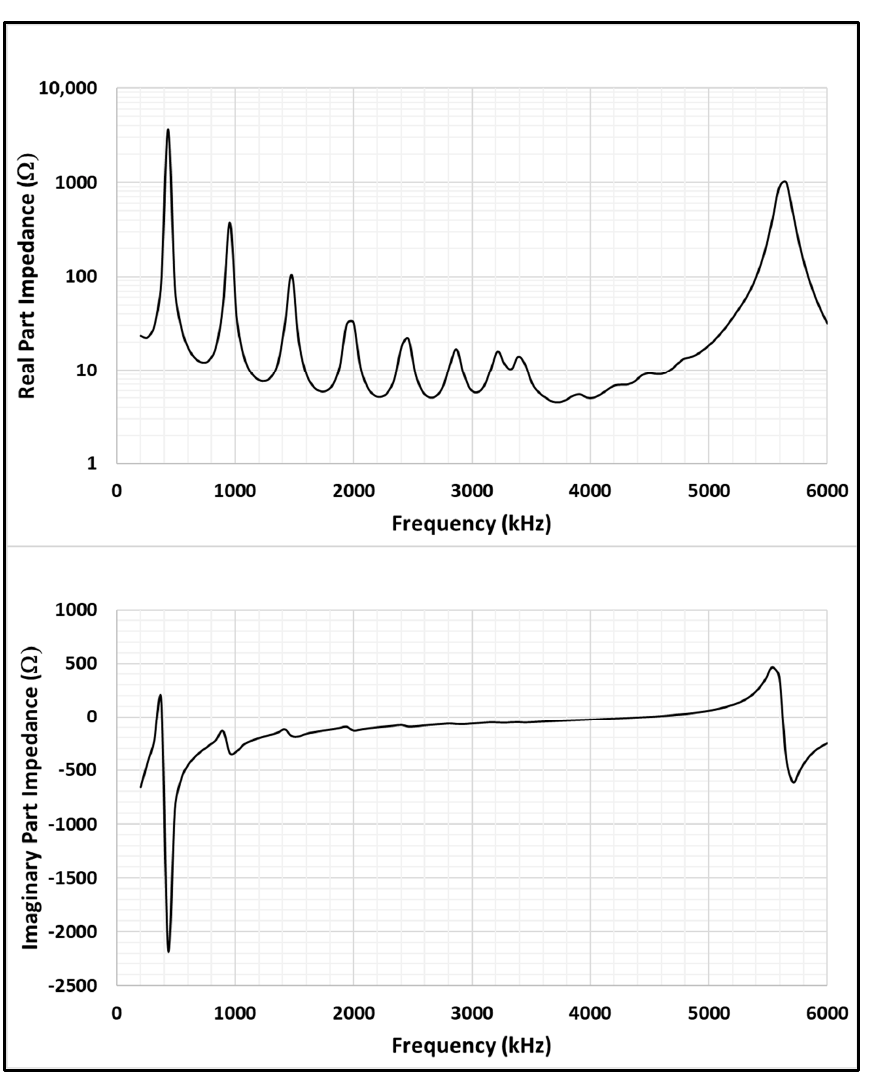
Figure 3. Free sensor analytical impedance response .